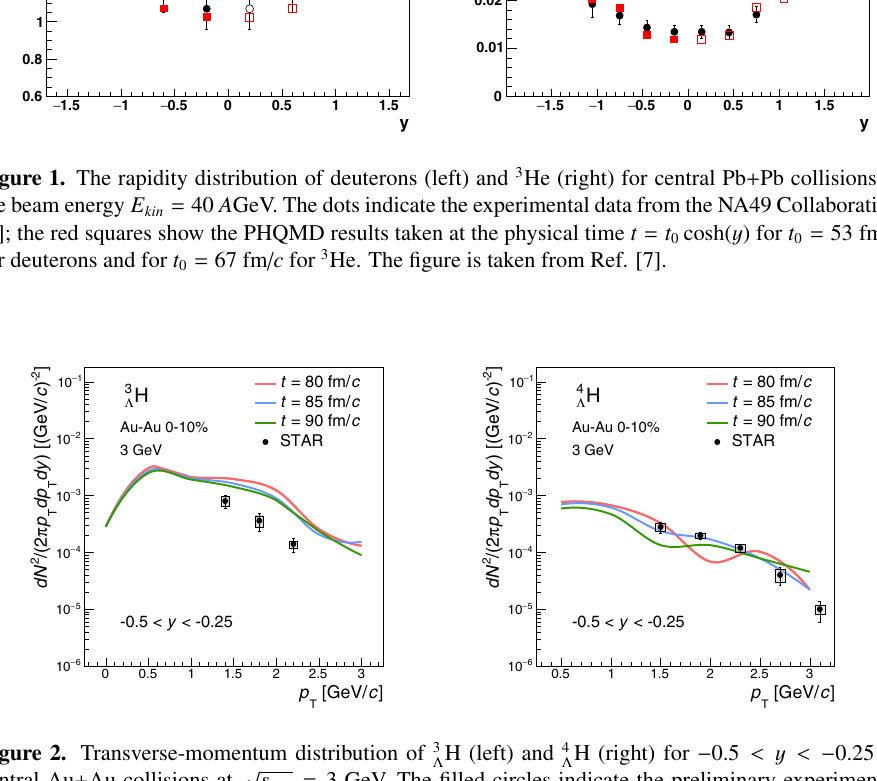
Figure 2. Transverse-momentum distribution of 3 central Au + Au collisions at √ s NN = 3 GeV. The filled circles indicate the preliminary experimental data from the STAR Collaboration [15]. The PHQMD results are taken at the times t = 80 fm / c (red lines), 85 fm / c (blue lines) and 90 fm / c (green lines). The figure is taken from Ref.